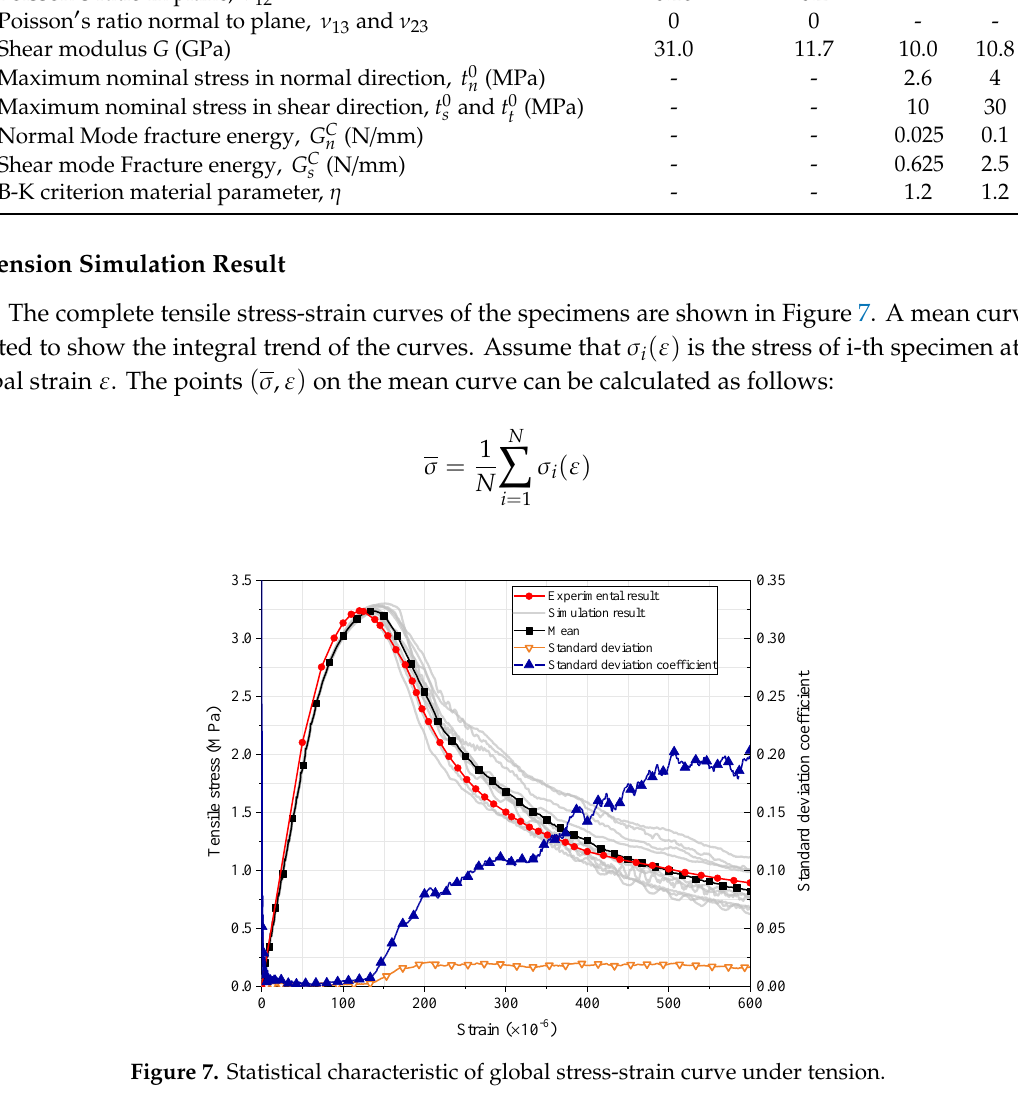
( a ) ( b ) Figure 8. Failure modes of the specimens under tension: ( a ) simulation result (with one dominant crack); ( b ) simulation result (with two dominant cracks). The specimen with one dominant crack in Figure 8 is selected for the deformation process analysis. In order to observe the whole deformation process, the deformation of the specimen is enlarged geometrically, as shown in Figure 10 . The specimen’s original deformation in the direction of tension is multiplied by a deformation scale factor v D to make the aspect ratio become 2:1 from 1:1. Eight characteristic states are selected to describe the deformation process. The corresponding points of the states are plotted on the stress-strain curve in Figure 9. After the specimen is loaded, before state A, the deformation evenly distributes at the aggregates and mortar, as shown in Figure 10a. The obvious plastic deformation appears since state B. Although the global stress hasn’t reached the damage initial stre ss of the ITZ elements, a few ITZ elements